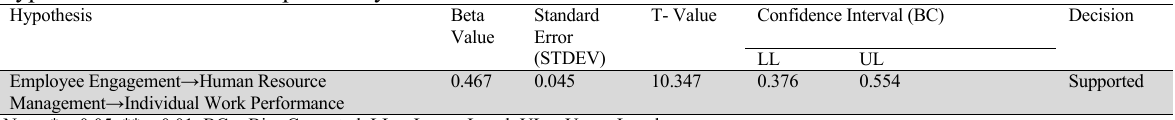
Hypothesis on mediation report analysis result Hypothesis Beta